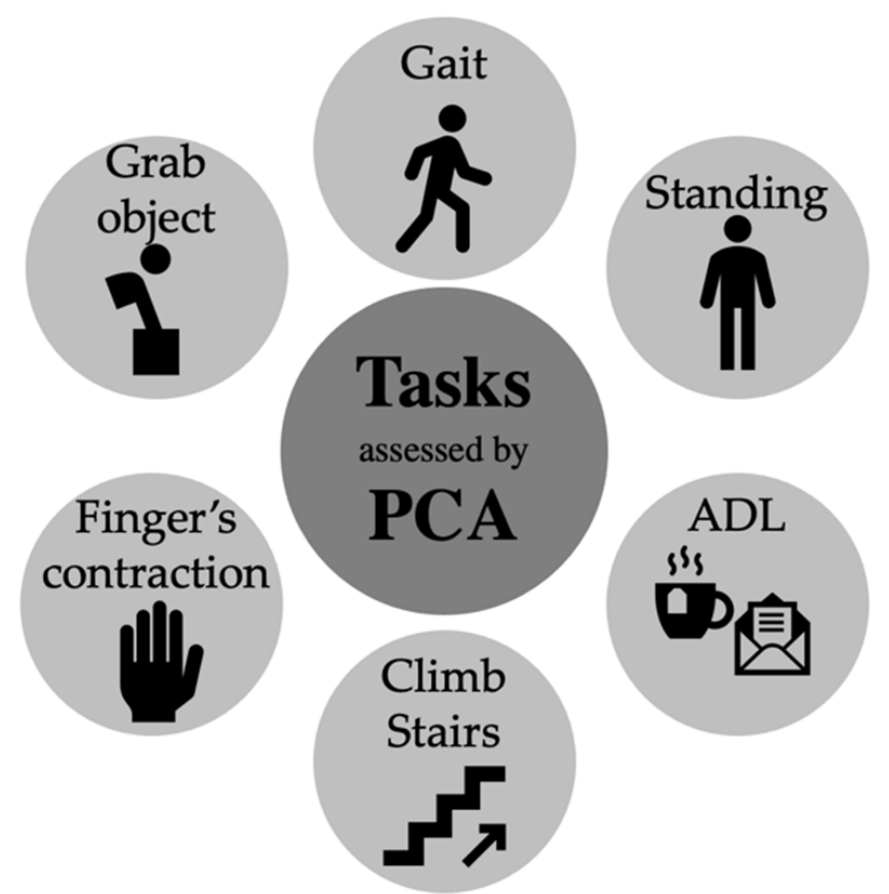
Figure 2. Summary of the older adults movement tasks analyzed and processed by PCA (ADL: Activity of daily living; PCA: Principal component analysis).